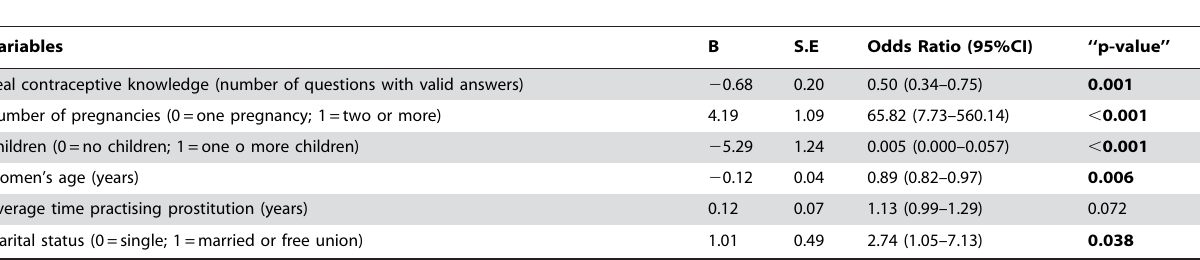
Table 4. Logistic regression to detect association between different variables and induced abortion.